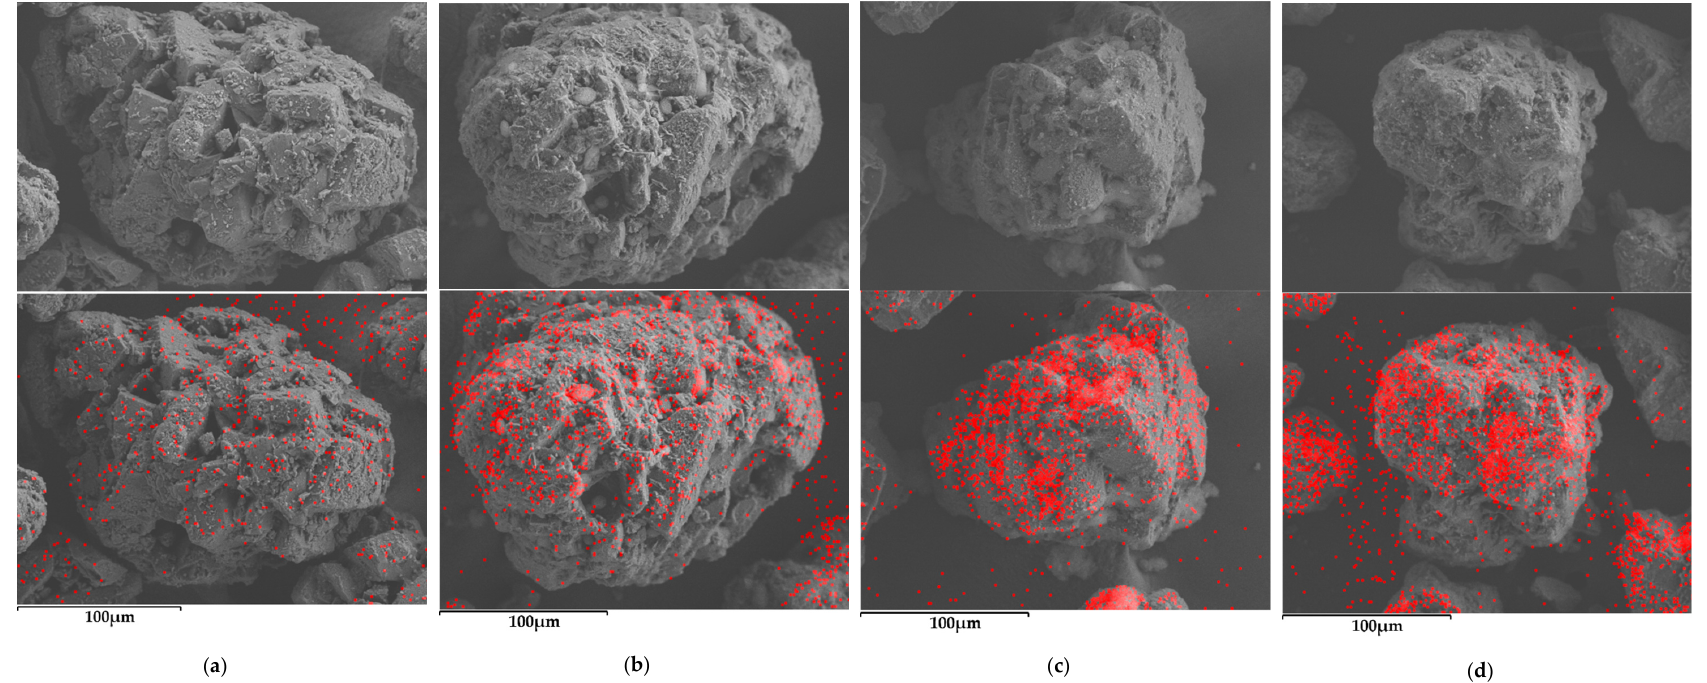
Figure 2. SEM (top) and EDS mapping (bottom) at 1 K magnification of ( a ) unprocessed FFL particle and FFL particle with 1.0% A200P, ( b ) after mixing in a V-Blender, after processing in the conical mill 4 times at ( c ) 476 rpm and ( d ) 1762 rpm. Red dots on bottom row are EDS mapping results of silicon.